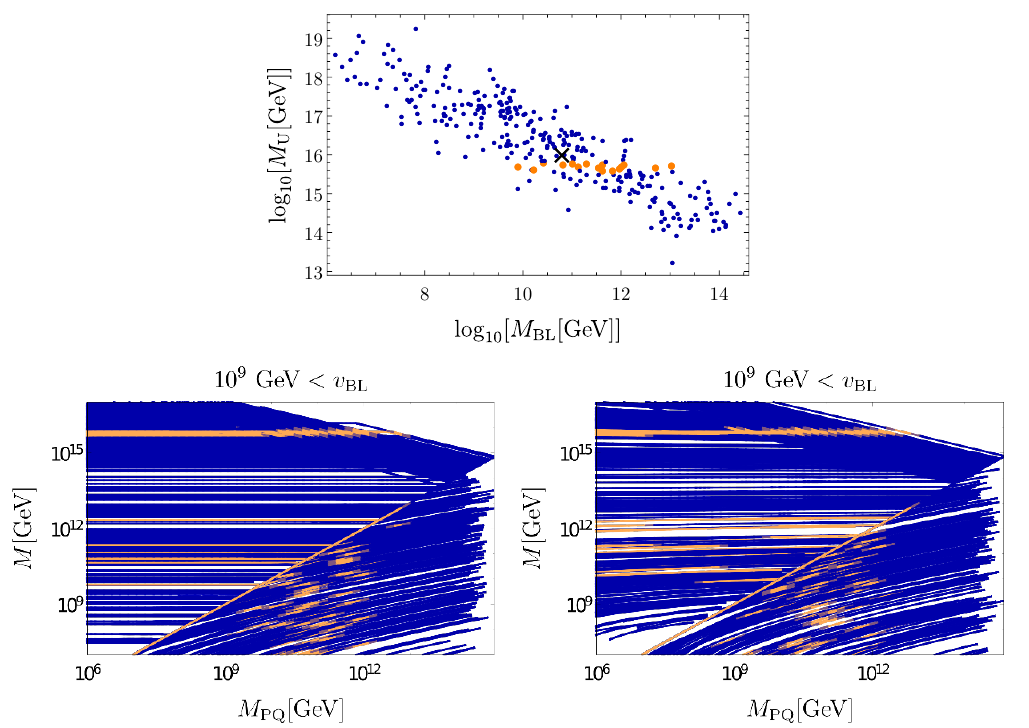
Figure 10 . Intermediate and uni(cid:12)cation scale for randomised scalar threshold corrections in Models 1 (top), 2.1 (bottom left) and 2.2 (bottom right) including the limit coming from a hypothetical observation of proton decay at Hyper-Kamiokande. Only the orange points/regions are not excluded by the constrained proton lifetime. For models 2.1 and 2.2, the threshold corrections induce large uncertainties in the viable f A ranges even in the case where the uni(cid:12)cation scale is known. heavy scalars, values of v of order 10 11 (cid:0) 10 12 GeV are still allowed. For v > 10 13 GeV, BL BL Model 3 is excluded. This is illustrated in lines 10 to 12 of (cid:12)gure